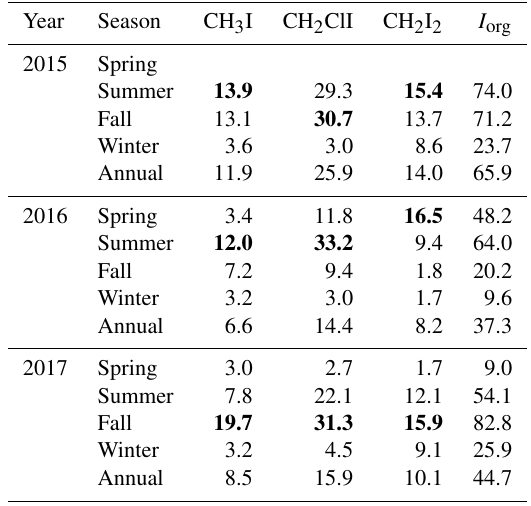
Table 3. Seasonal variation of total sea-to-air fluxes of iodocarbons (nmolm − 2 day − 1 ). The highest flux values of iodocarbons in each year are marked in